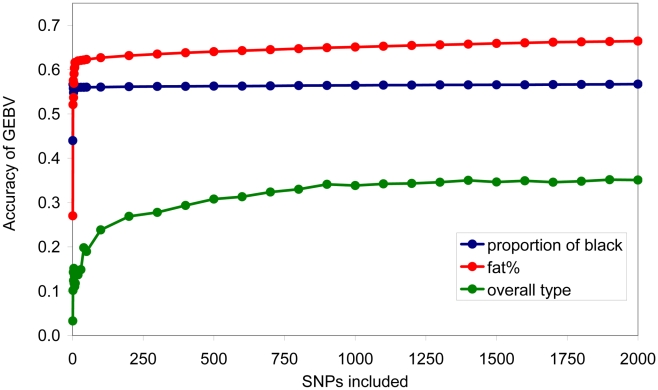
Accuracy of genomic breeding value (GEBV) when a given number of SNPs of largest effect are used to calculate the GEBV.